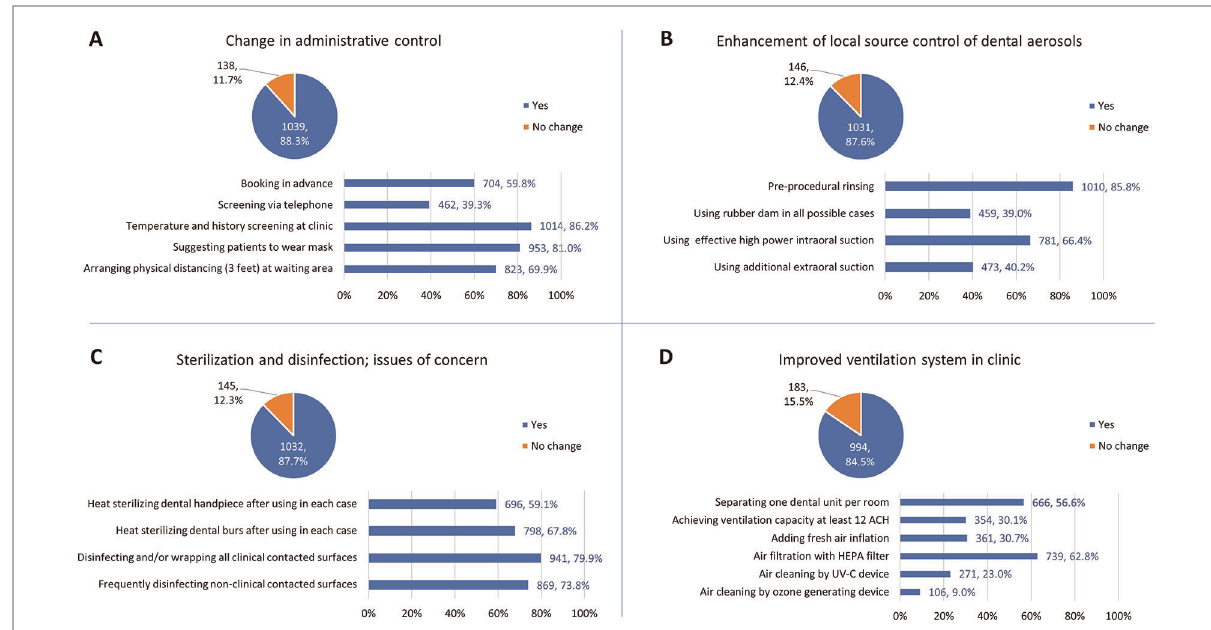
FIGURE 2 Changes in administrative control ( A ), local source control of dental aerosols ( B ), sterilization and disinfection practice ( C ), and ventilation system in the clinic ( D ) ( N , %). A large and similar proportion of respondents, 85% – 88%, reported change in these measures. Among those reported no change in all four mentioned measures, 136 participants suspended their operations instead of continuing under modi fi ed